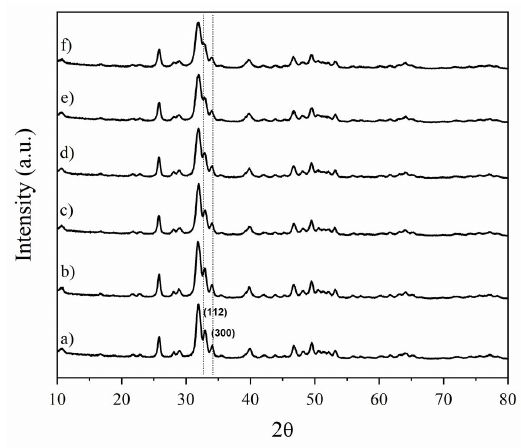
Figure 3. XRD patterns of (a) HAp-600, (b) HAS0.5-600, (c) HAS1- 600, (d) HAS2-600, (e) HAS3-600 and (f) HAS4-600